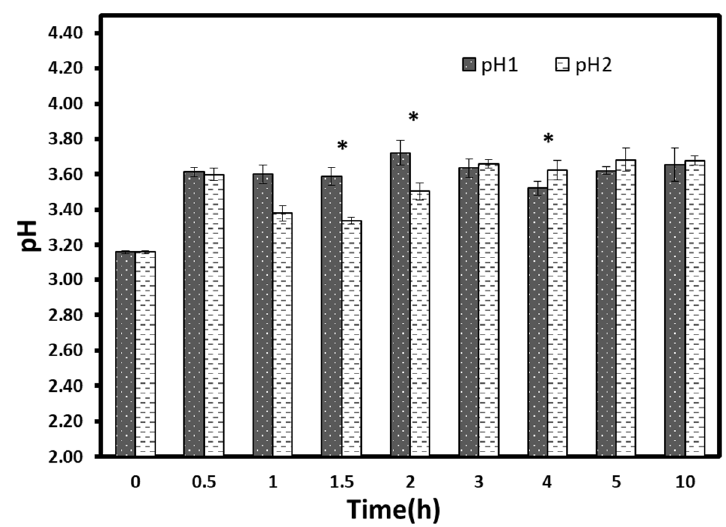
Figure 7. pH evolution during osmotic dehydration at atmospheric (pH 1) and vacuum (pH 2) pressures. Each point represents the mean and standard deviation of a duplicate of three repetitions. * Significant difference between time groups.